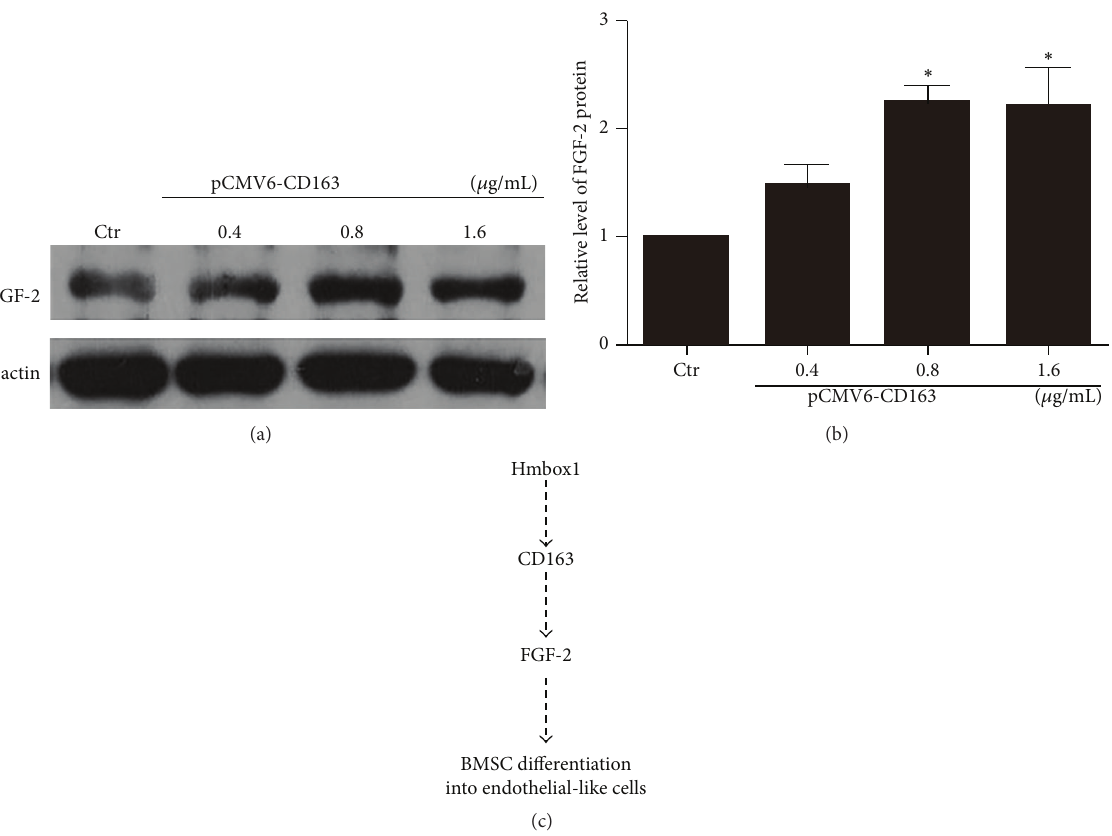
Figure 5: CD163 acted upstream FGF-2 in BMSC differentiation into a vascular endothelial lineage. (a) Western blot analysis of the protein level of FGF-2 after overexpression of CD163. (b) Relative protein levels of FGF-2 were calculated based on densitometry analysis. Data are mean ± SEM. ∗ 𝑝 < 0.05 , ∗∗ 𝑝 < 0.01 versus control (Ctr), 𝑛 ≥ 3 . (c) A conceptual schematic of CD163 involved in the differentiation of BMSCs into a vascular endothelial lineage. Hmbox1 increases the expression of CD163, which promotes BMSC differentiation into vascular endothelial-like cells by enhancing